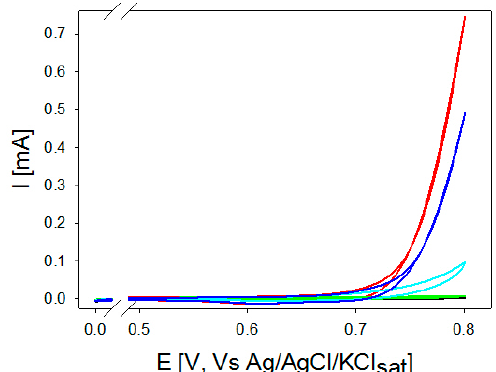
Figure 2. Cyclic voltammetry curves recorded on a steel AISI 316L WE. 50 mV/s potential scan rate, Pt sheet as CE and Ag/AgCl/KCl sat as RE. KOH 0.1 M aqueous solution is the base electrolyte. L -( − )-aspartic acid concentration: (red) 0 mM, (blue) 1 mM, (light blue) 10 mM, (green) 50 mM, (black) 100 mM.